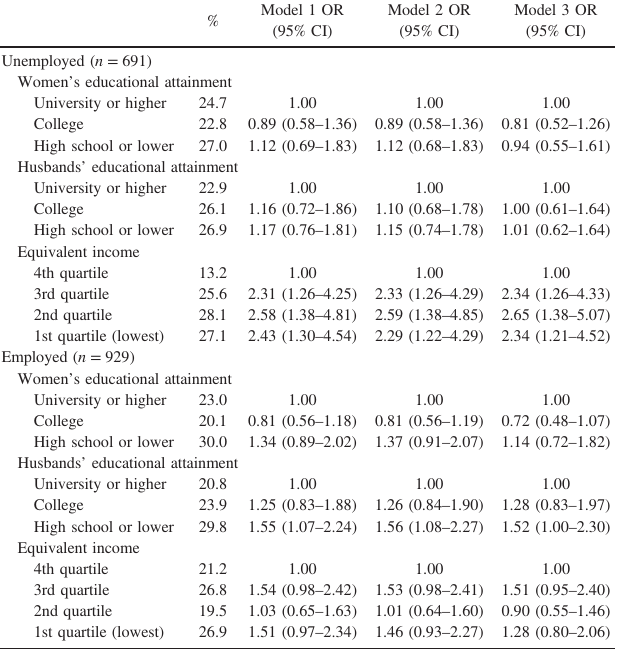
Table 4. Prevalence and odds ratios for poor oral health by employment status among married women ( n = 1,620)